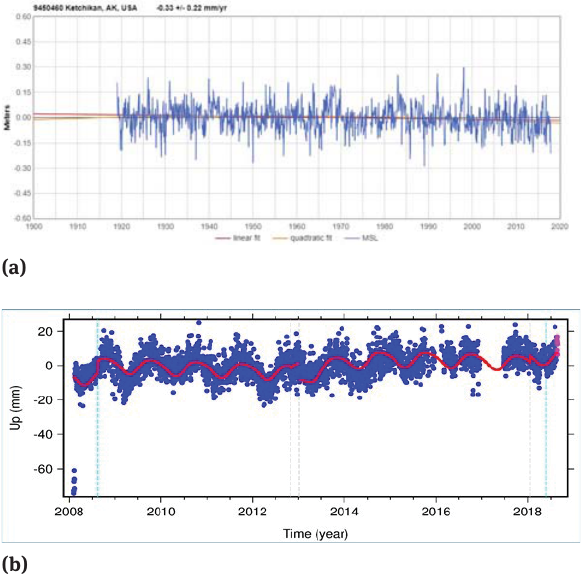
Figure 22: (a) MSL data for Balboa, Panama. Image reproduced modified after